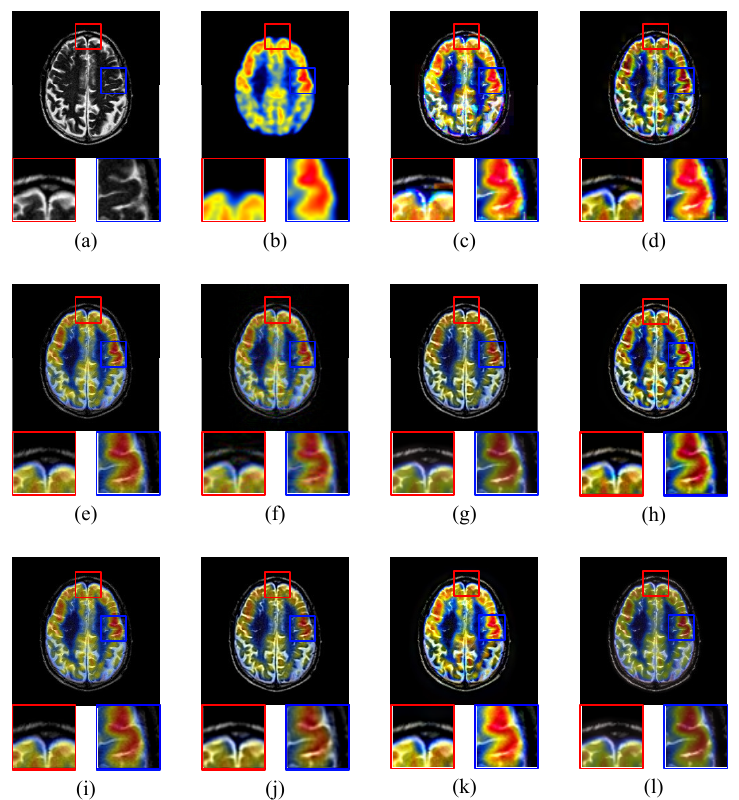
Figure 7. MRI-PET Image Fusion Comparative Experiments, ( a ) is the MRI source image; ( b ) is the PET source image; and ( c )–( l ) are the fused images of BSD, DWT, DT-CWT, CS-DCT, KSVD-OMP, MFR, SRDL, JPC, MST-SR, and the proposed IDLE